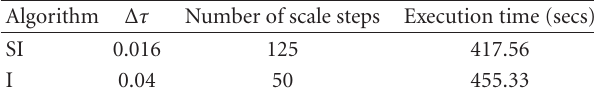
Table 9: Test 2: Comparisons between two algorithms: E d = O (10 − 2 ).